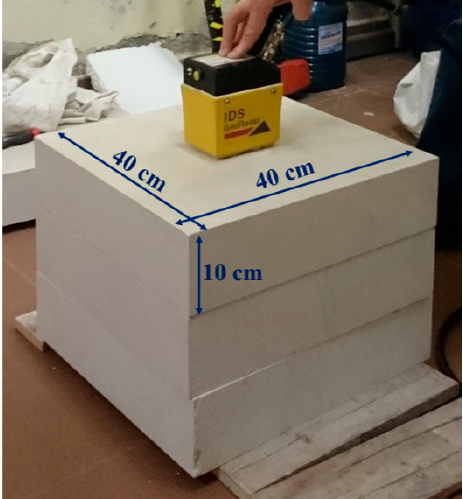
Figure 2. Time-triggered GPR measurements with the antenna fixed in the center of the marble